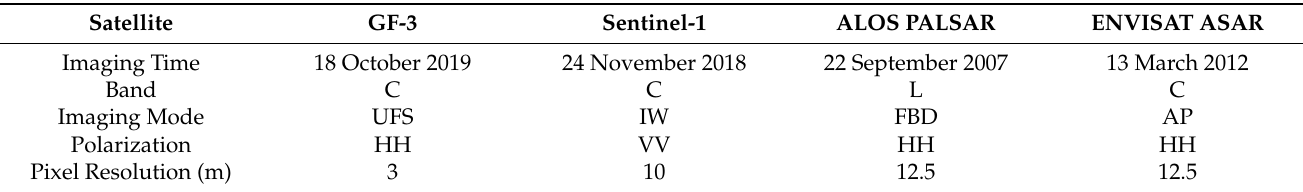
Table 1. The parameters of the four satellites.